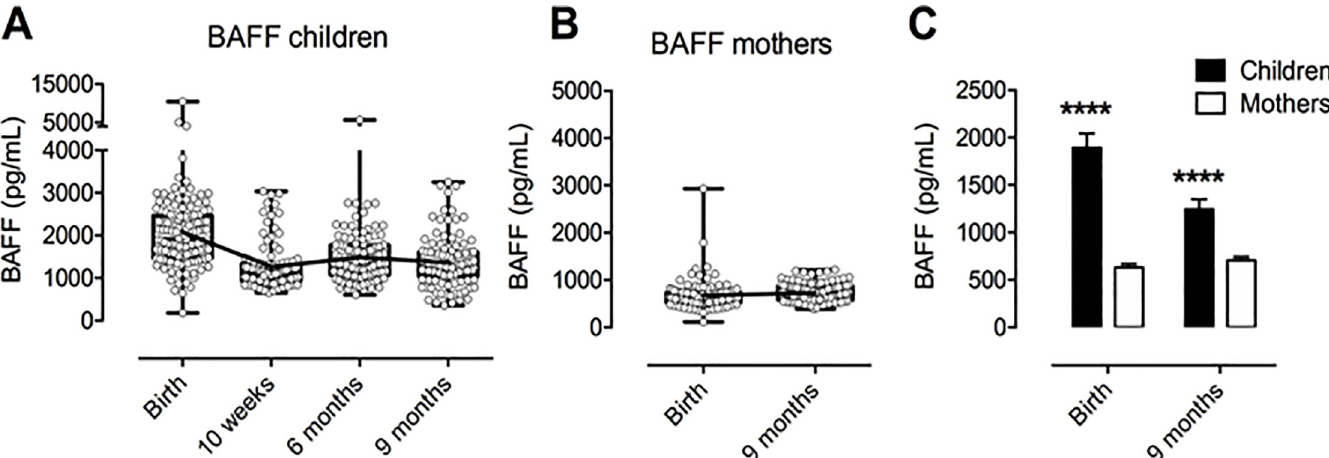
Fig 1. Distribution of individual and mean levels of measured BAFF concentrations for children and mothers at each time point. A) BAFF levels in children over the course of the study. B) BAFF levels in mothers at birth and 9 months postpartum. C) Comparison of mean BAFF levels in children and mothers at birth and at 9 months using unpaired t test with Welch’s correction. ���� p < 0.0001. All figs show bars and errors with geometric mean + 95% confidence interval. For A, B: Mean values indicated by interconnecting